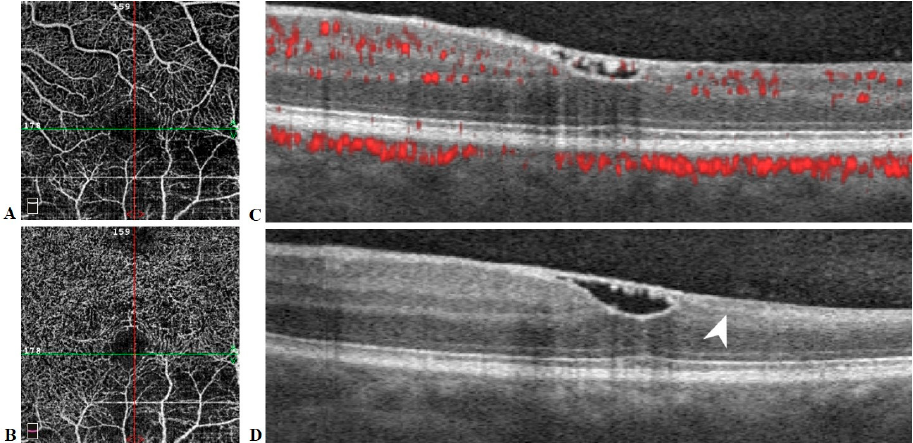
Figure 6. Optical coherence tomography angiography (OCTA) en face images ( A , B ) and spectral domain OCT B-scans ( C , D ) of the left eye at 11 weeks follow-up. Decreased vessel density of the superficial ( A ) and deep ( B ) retinal capillary plexuses is noted inferiorly in the area of arterial occlusion. A contiguous membrane with mild residual hyper-reflective hemorrhage underneath traverses the foveal depression ( C , D ). Vertical ( D ) OCT shows significant thinning of inner retinal layers of the inferior macula (arrowhead).